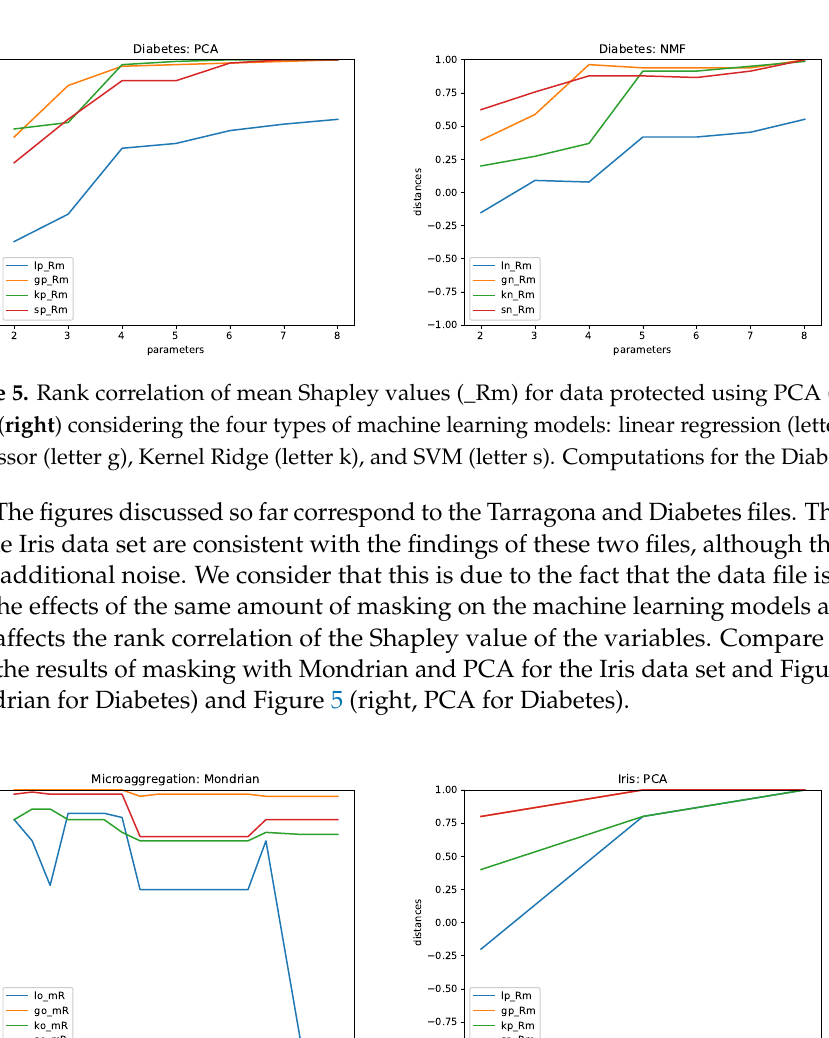
Figure 4. Rank correlation of mean Shapley values (_Rm) for noise addition for Gaussian noise ( left ) and Laplacian noise ( right ) considering the four types of machine learning models: linear regression (letter l), SGD Regressor (letter g), Kernel Ridge (letter k), and SVM (letter s). Computations for the Diabetes file.